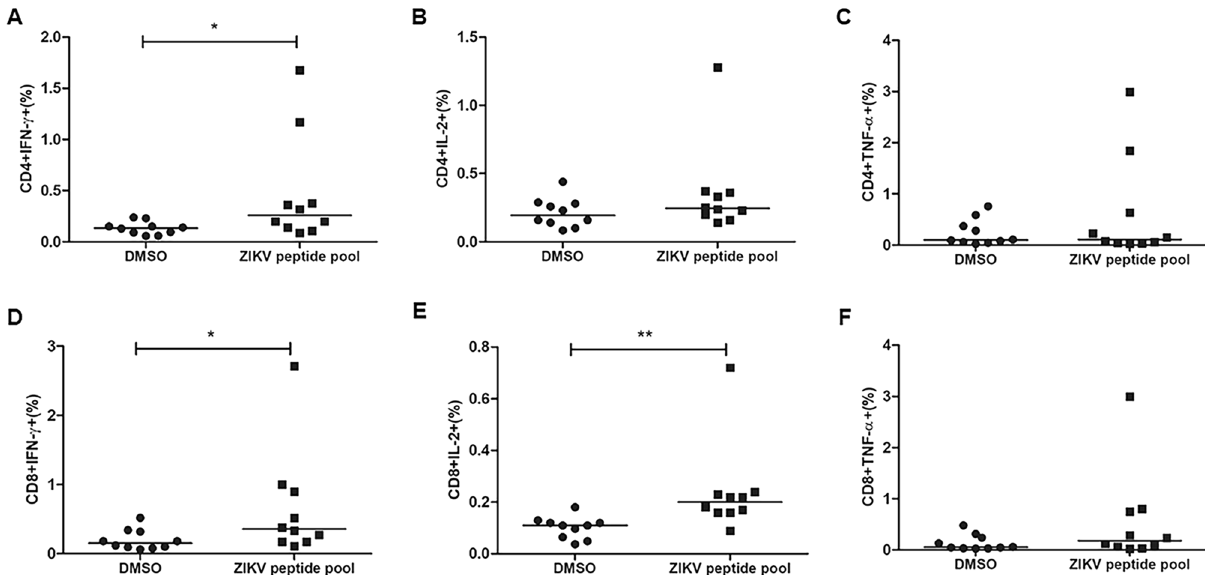
Figure 7. CD4 + and CD8 + T cell responses to ZIKV peptides. PBMC of 10 individuals with previous infection to ZIKV were stimulated for 5 h with the ZIKV peptide pool. After 1 h of stimulation, Brefeldin A was added. The cells were stained with antibodies for the surface markers CD3, CD4 and CD8 and intracellular stained with anti-IFN-γ, IL-2 and anti-TNF-α. IFN-γ, IL-2 and TNF-α production by CD4 + T cells ( A–C ) and CD8 + T cells ( D–F ) was evaluated by flow cytometry. The horizontal lines indicate the medians. Mann–Whitney test was performed to determine statistical significance and p < 0.05 was considered